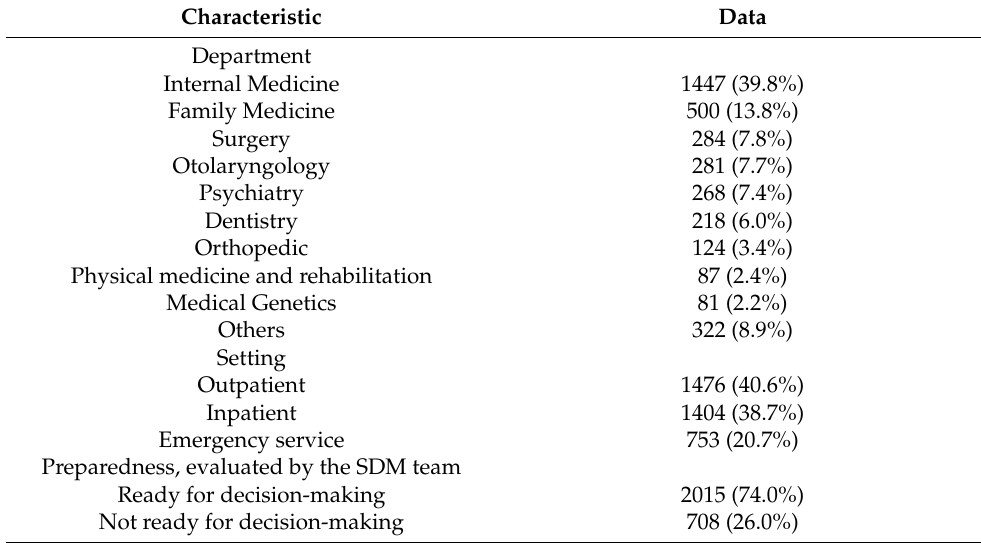
Figure 2. Cumulative numbers of implemented online SDM topics and cumulative SDM cases during the study period. Table 2. SDM cases for the analysis ( n =